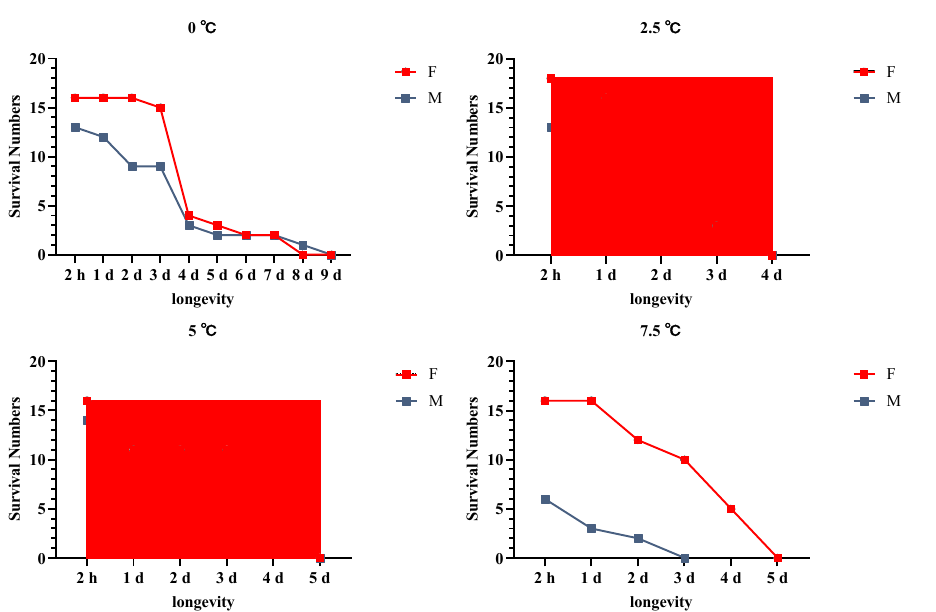
Figure 5. The longevity of Agasicles hygrophila adults after rapid cold-hardening and discrimination temperature treatment. Differences in the longevity of adults after different periods of recovery were analyzed using a repeated-measures ANOVA, followed by the LSD test ( p < 0.05). All values are presented as the mean ± SE.